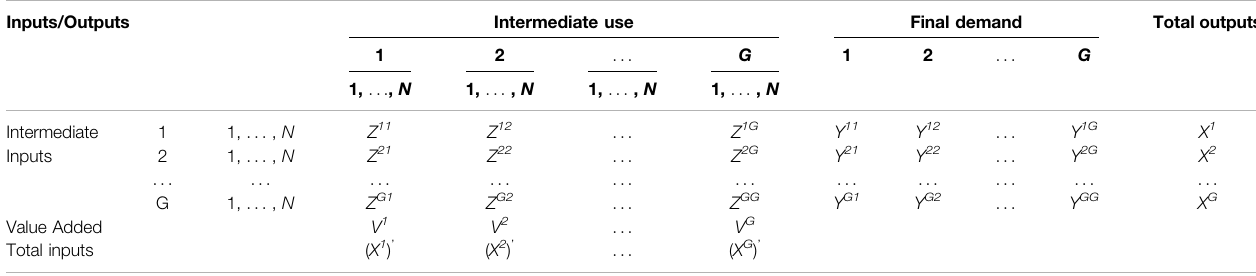
TABLE 1 | Global multi-regional input-output